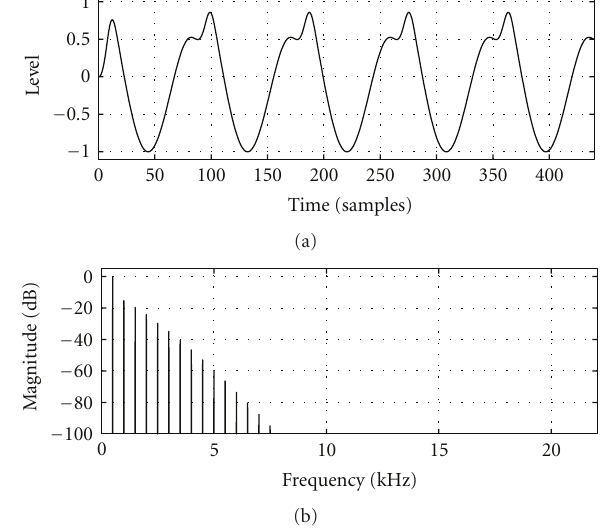
Figure 11: Waveform and spectrum of FBAM variation 1 ( β = 1, f 0 = 500Hz), see Figure 10(a).